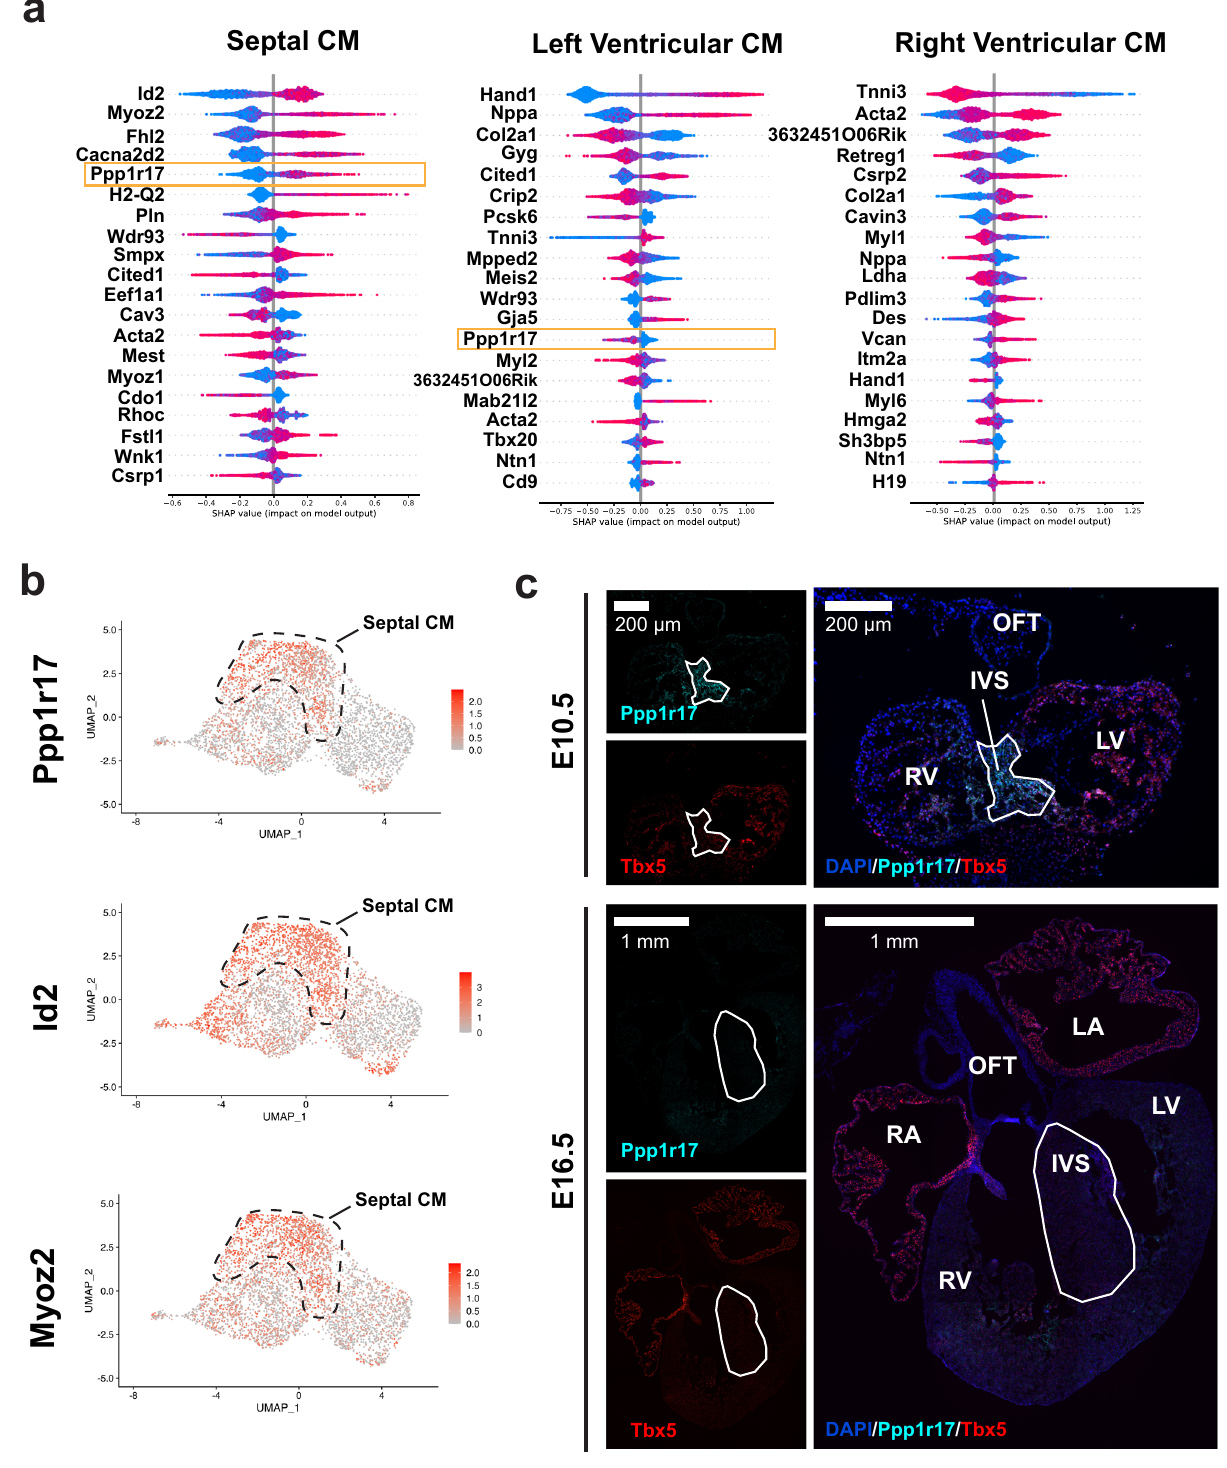
Fig. 5 | Identi fi cation of Septal Marker Ppp1r17 by devCellPy . devCellPy feature ranking using the SHAP algorithm identi fi ed markers of septal cardiomyocyte identity. a Top positive and negative predictors of ventricular cardiomyocyte identity at E10.5. Orange box indicates the identi fi cation of Ppp1r17 as a septal marker. b Feature plots indicating the expression of three putative septal markers